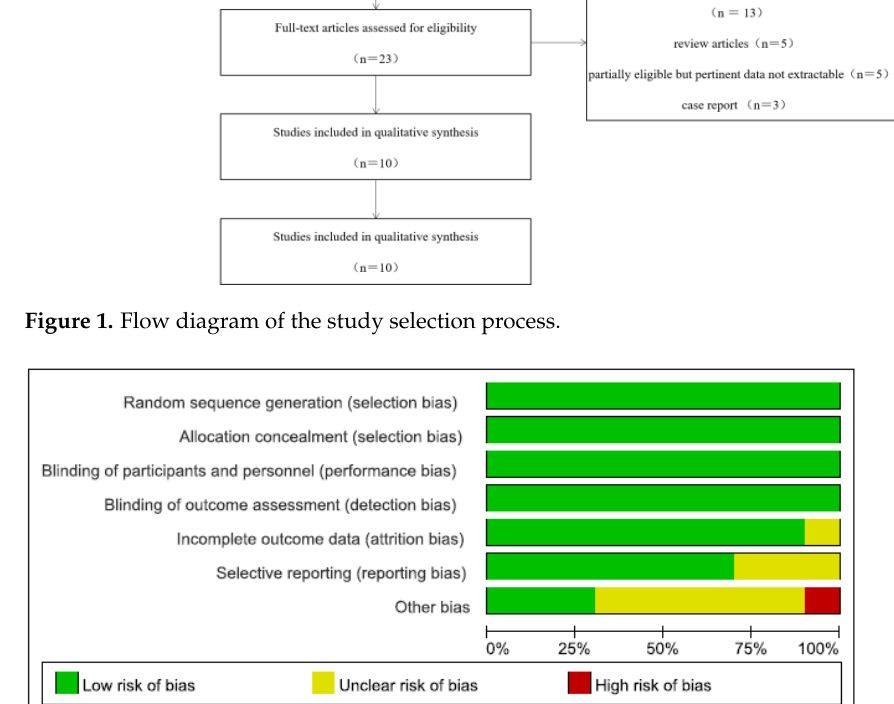
Figure 2. Risk of bias: a summary table for each risk of bias item for each study.